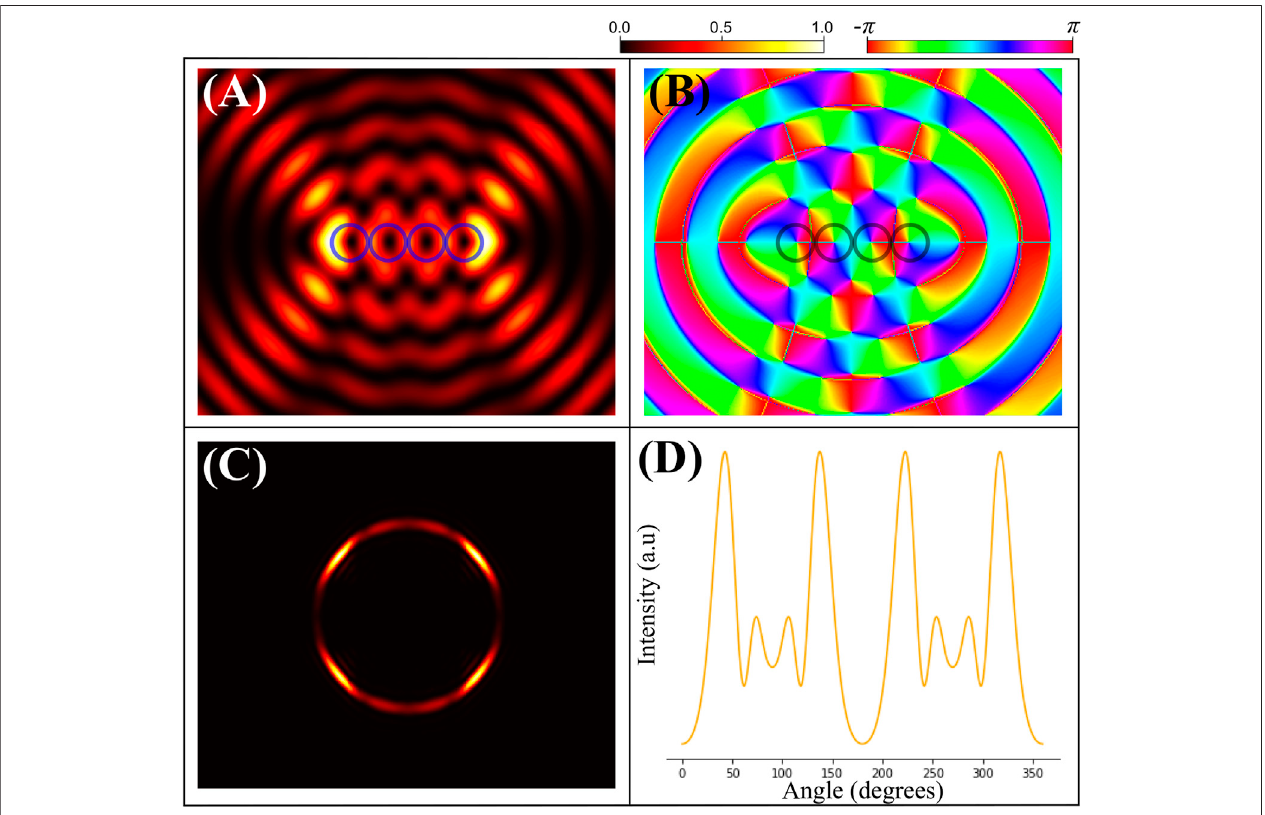
FIGURE2| PlotssimulatingahelicalMathieu – Gaussbeamoforder4(chosen toprepareHM-G). (A) Intensitypro fi le; (B) spatialdependencyofitsphase.Theblue circles on (A) and (B) enclose zero- fi eld regions where optical vortices are expected. (C) Fourier ring formed at the focal length of the lens used for its experimental manipulation, and the orange curve in (D) illustrates the corresponding angular